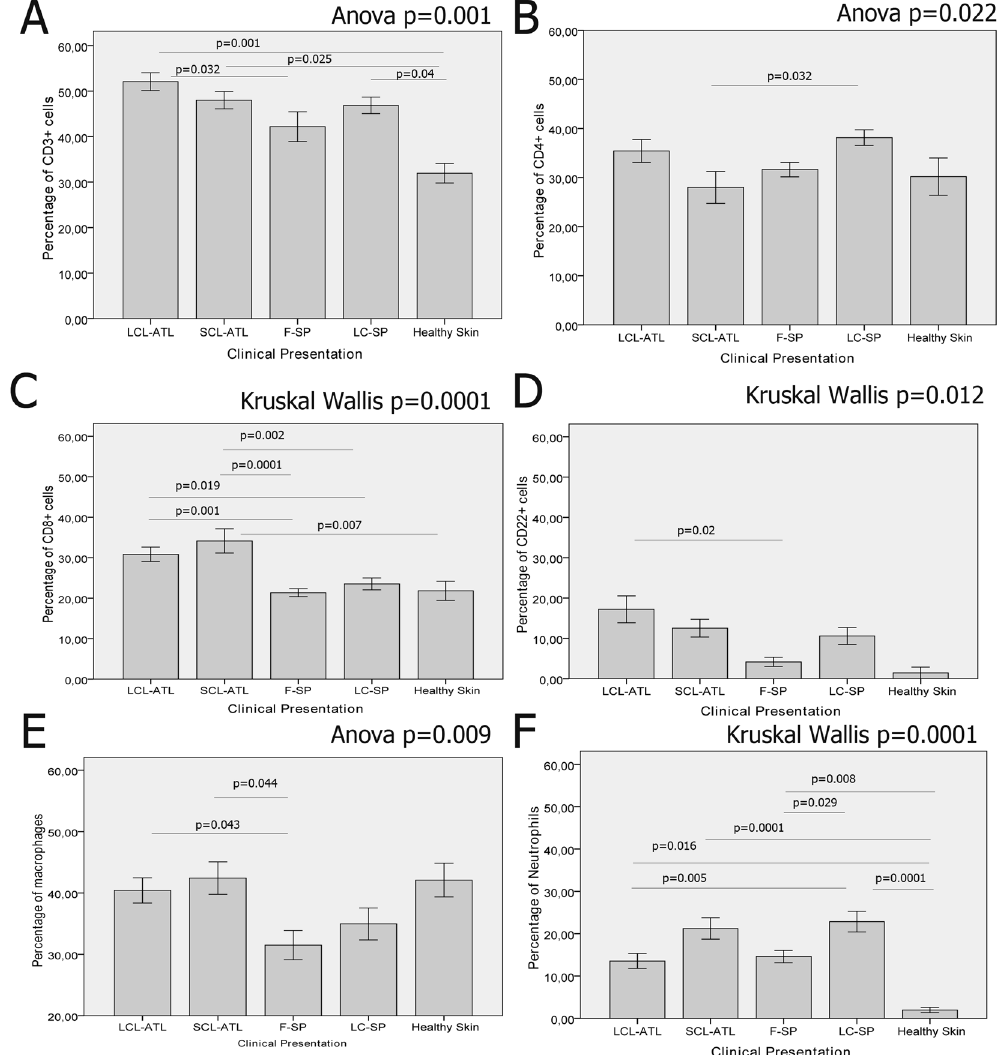
Figure 3. Percentage of ( A ) CD3 + , ( B ) CD4 + , ( C ) CD8 + , ( D ) CD22 + cells, ( E ) macrophages (CD68 + cells) and ( F ) neutrophilic elastase-positive cells (neutrophils) Data represented as mean and SEM. P-value < 0.05 was considered statistically significant. LCL-ATL: localized cutaneous leishmaniasis; SCL-ATL: sporotrichoid cutaneous leishmaniasis; F-SP: fixed sporotrichosis; LC-SP: Lymphocutaneous sporotrichosis. Anova test was used for variables with normal distribution, otherwise Kruskal-Wallis test was applied. Bonferroni test was used as post hoc test. Pis modi aliquatem ad magnate erupis nulpari busam, nimus aut aut odi comniatur